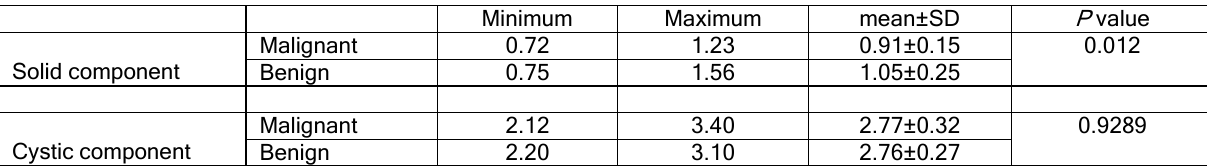
Table 6: Comparison of the ADC values in solid and cystic components in benign and malignant ovarian lesions (ADC (*10-3) mm² /s).